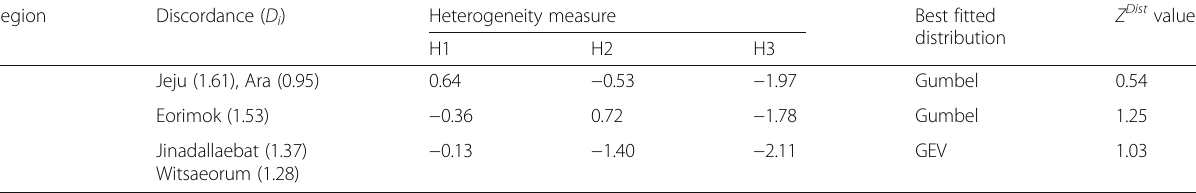
Table 3 Discordance, heterogeneity measure and best fitted distribution for three regions Region Discordance ( D i